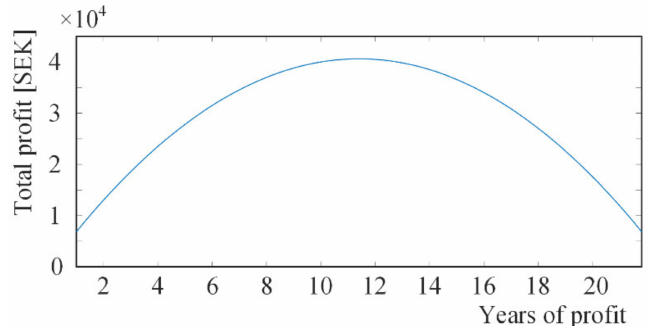
Figure 17. The total profit versus the years of